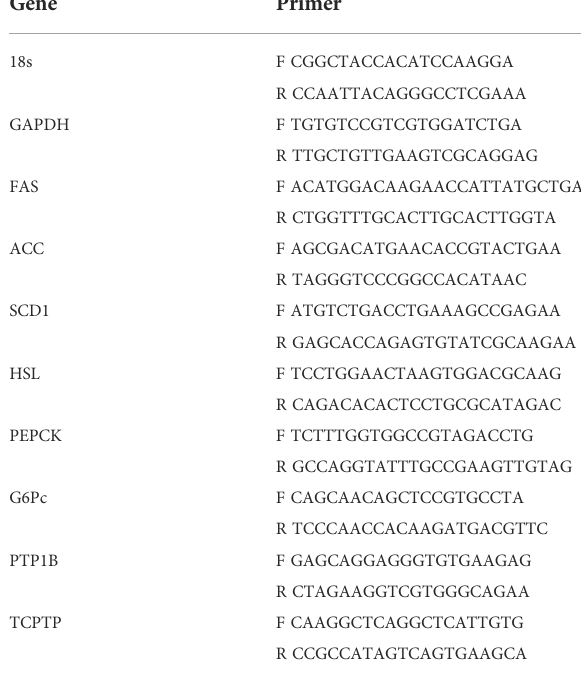
TABLE 2 Primer sequences for real-time PCR